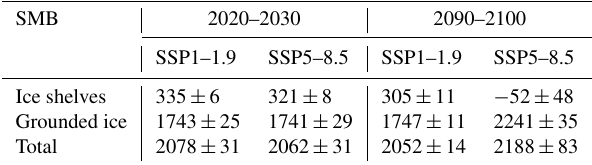
Table 2. Ensemble mean of decadal-mean area-integrated SMB (Gtyr − 1 ) on ice shelves and grounded ice from SSP1–1.9 and SSP5–8.5 simulations for 2020–2030 and 2090–2100. The standard deviation indicates the ensemble